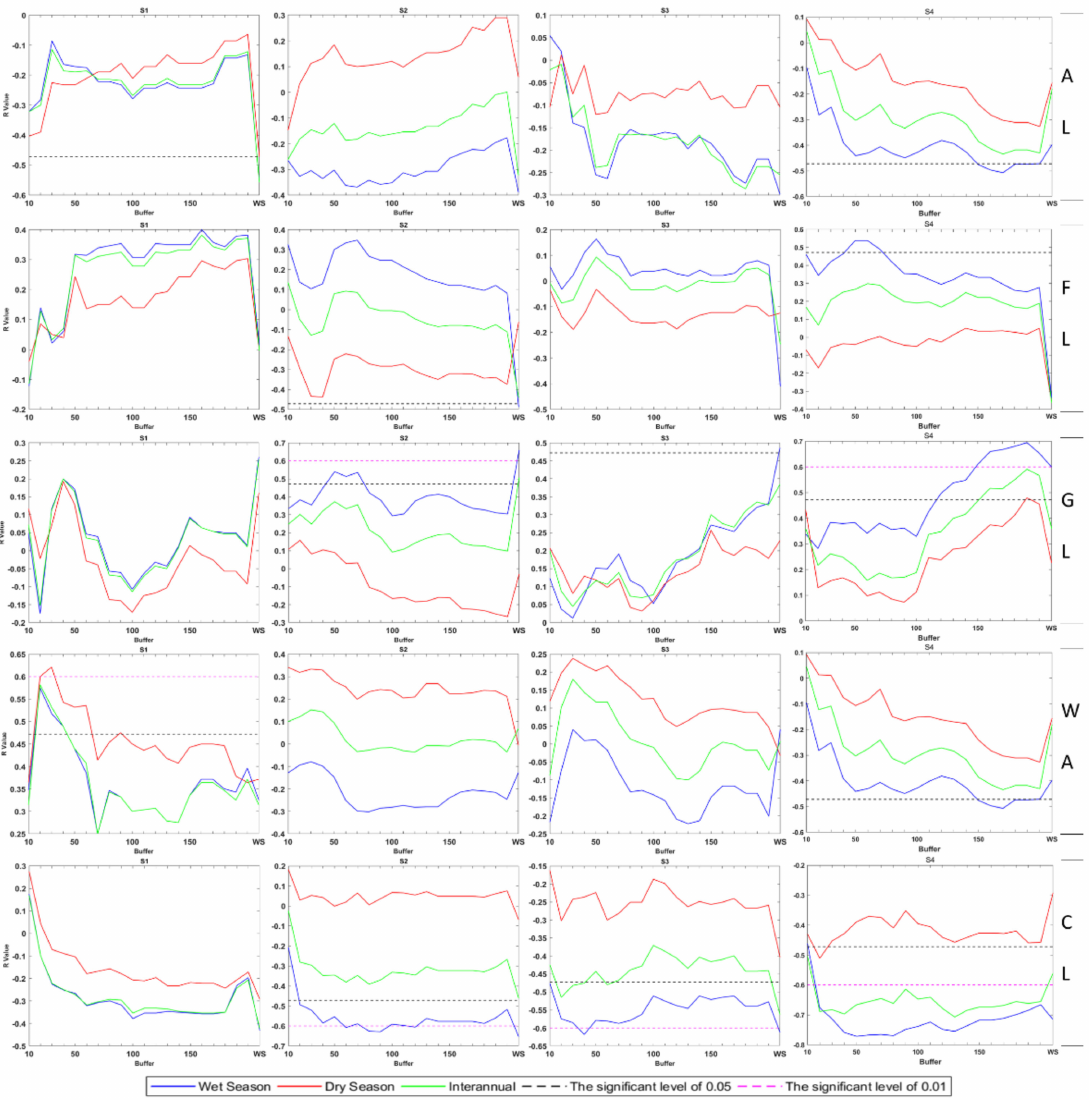
Figure 11. Correlation index of DO and different land use types in different seasons in S1, S2, S3, and S4. Each row from the top to the bottom represents a type of land